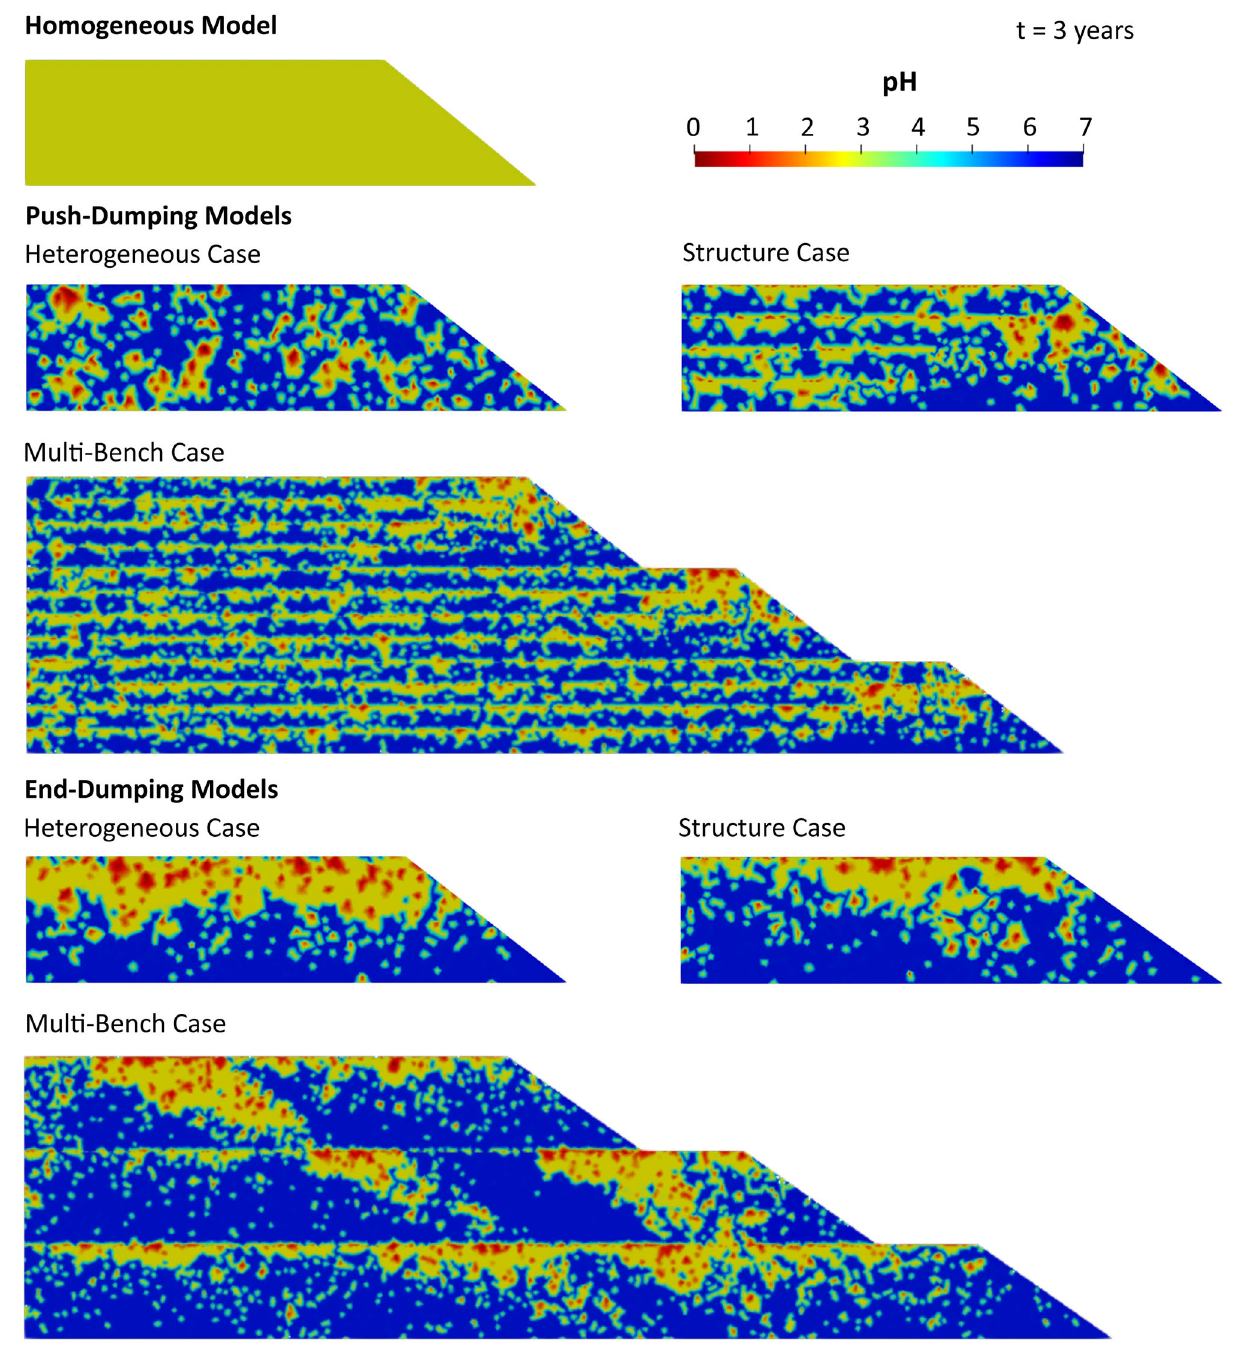
FIGURE 8 | pH cross sections at t = 3 years comparing “heterogeneous” vs. “structure” models. To visualize the progression of pH evolution over 50 years, see animations and Supplementary Table 2